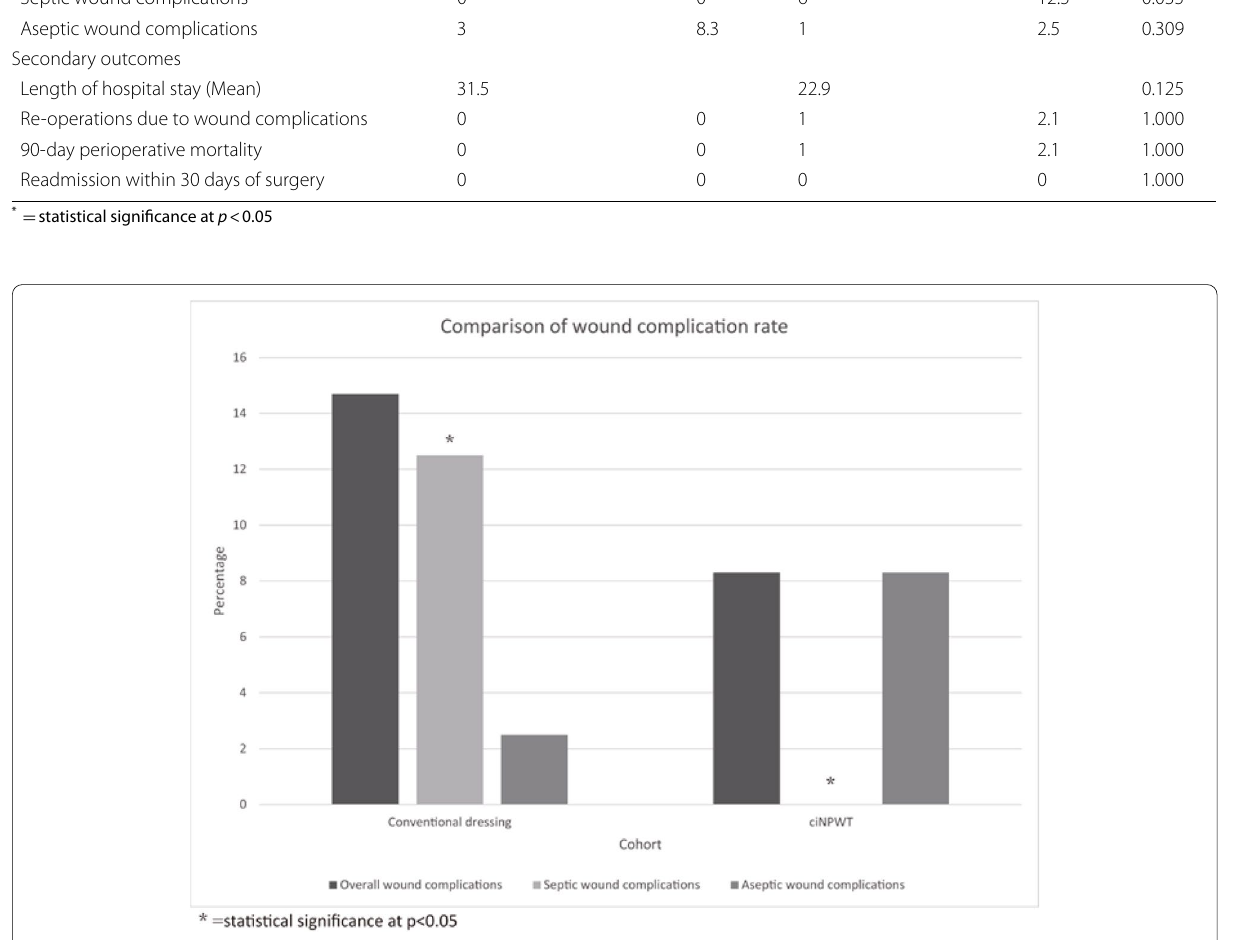
statistical significance at p =